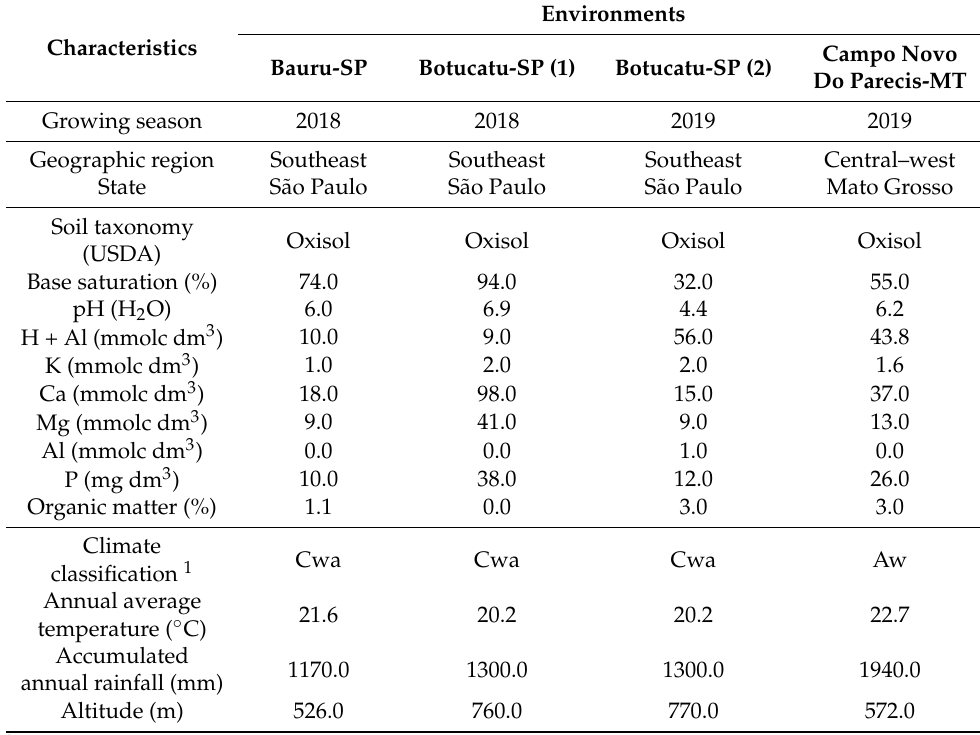
Table 1. Details of safflower testing